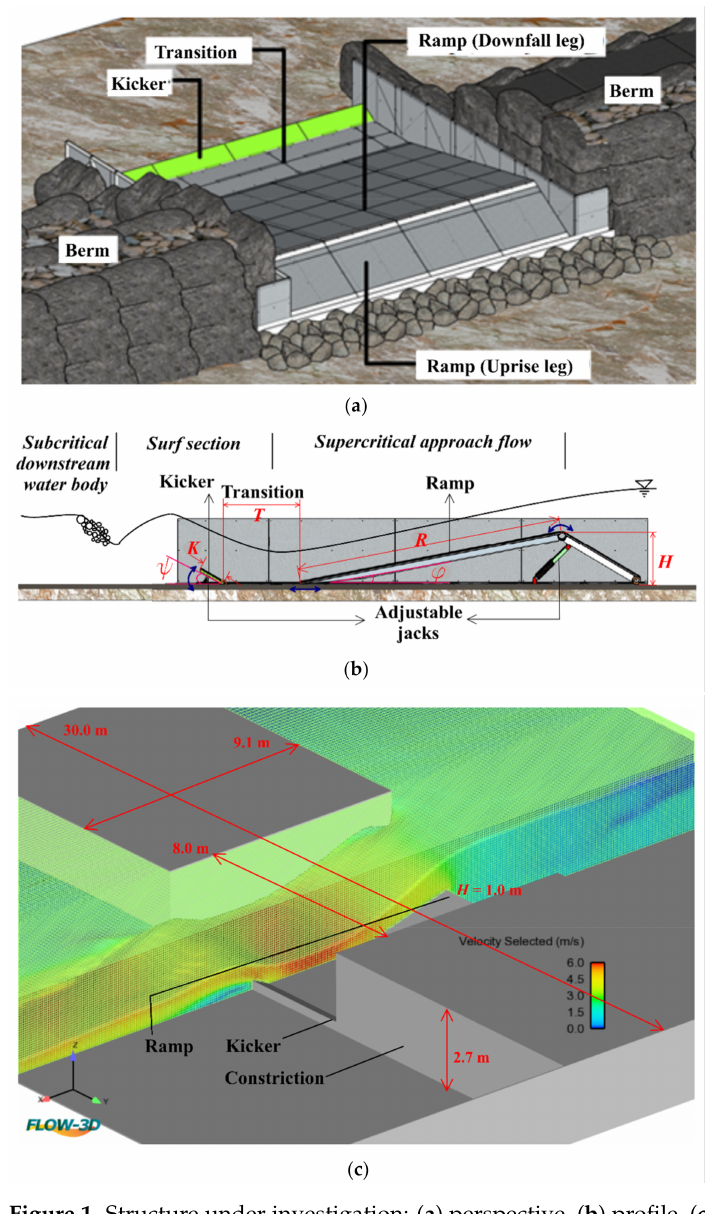
Figure 1. Structure under investigation: ( a ) perspective, ( b ) profile, ( c ) geometry of the numerical model (this does not show the full model extent to the upstream and downstream